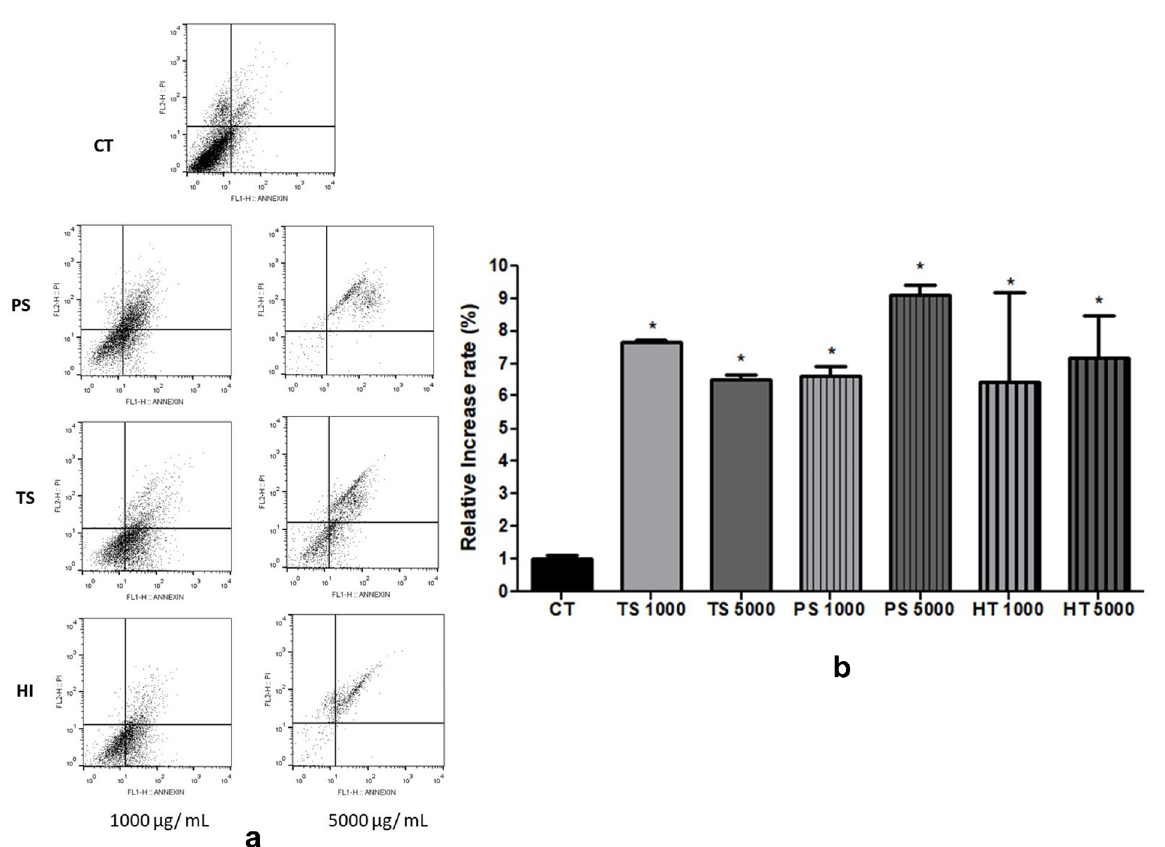
Figure 5. Increased relative rate of apoptosis in MDA-MB 435(a and b) treated for 48 hrs, with 1000 and 5000 μg/ mL of Pedro Sato (PS), Tsumori (TS) and Hitigio (HI) guava cultivars extracts. Results were compared by One- way ANOVA followed by Tukey test for significance (* p<0.05; p <0.01). CT= Results of untreated (CT) and treated